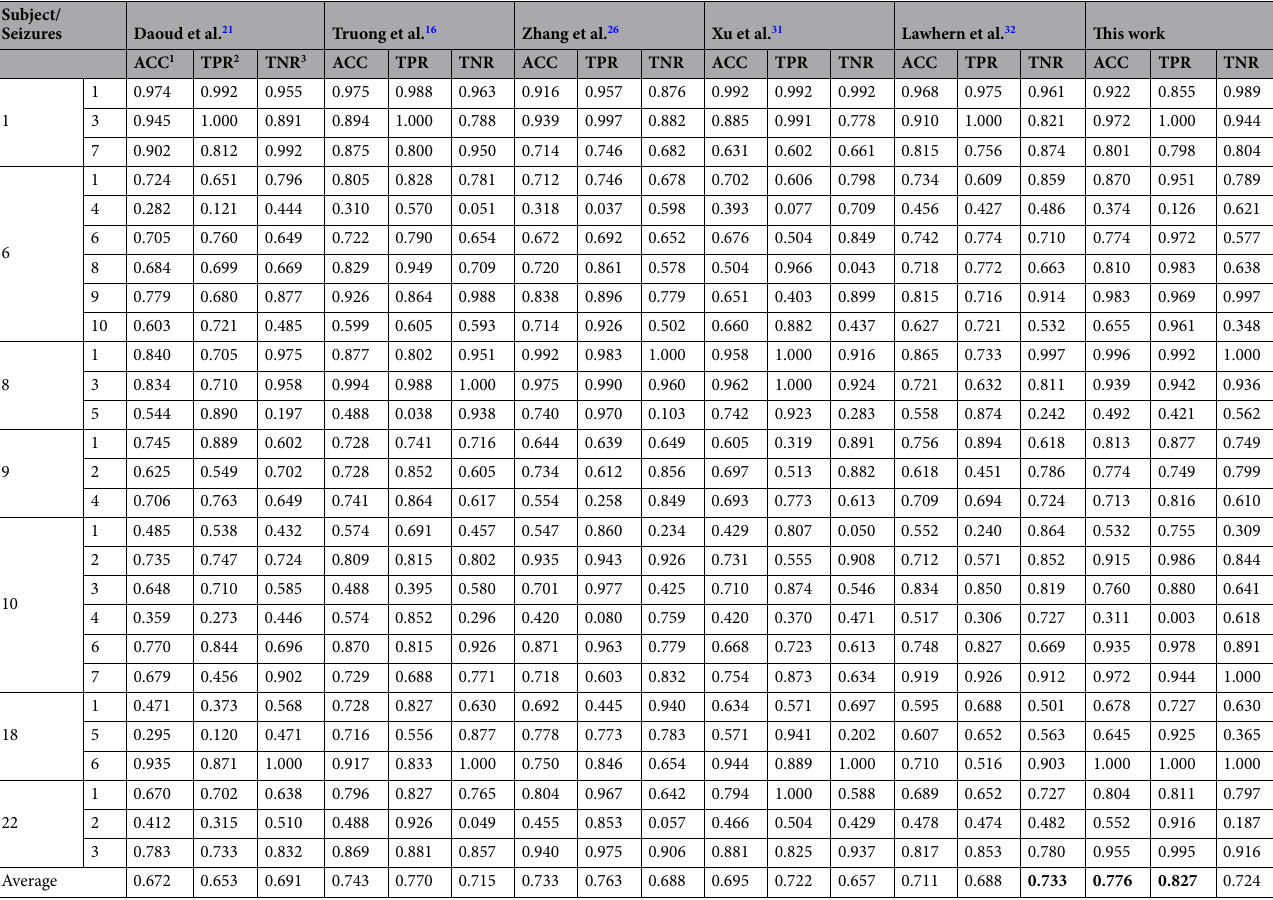
Table 3. Evaluation results of using leave-one-out cross-validation method to test different models. The first two columns refer to the subjects and the number of seizures used as the test set. 1 Accuracy. 2 True positive rate (Sensitivity). 3 True negative rate (Specificity).